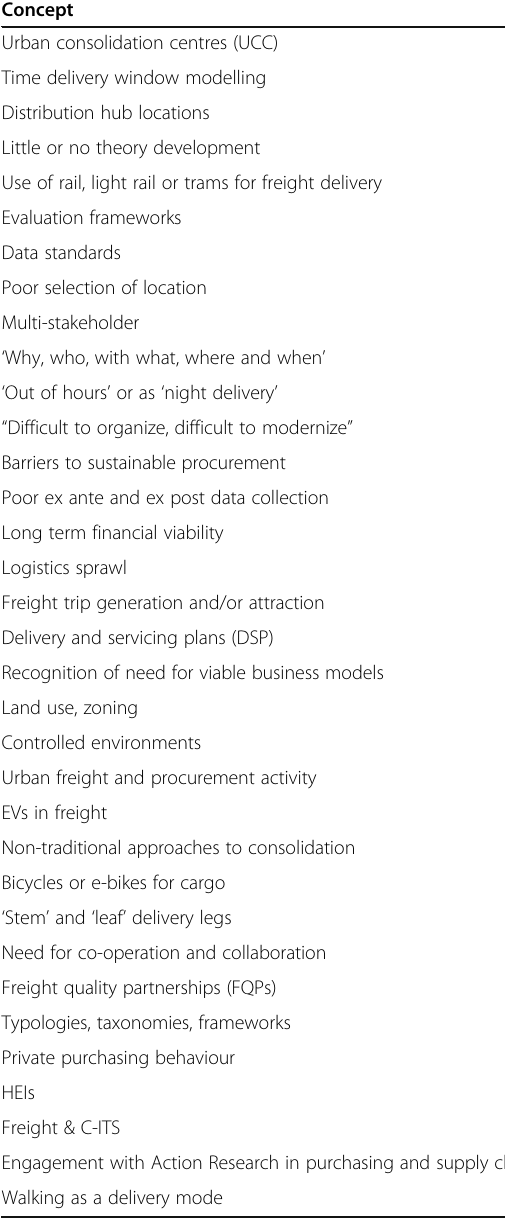
Table 4 Synopsis of concepts and the key years of emergence